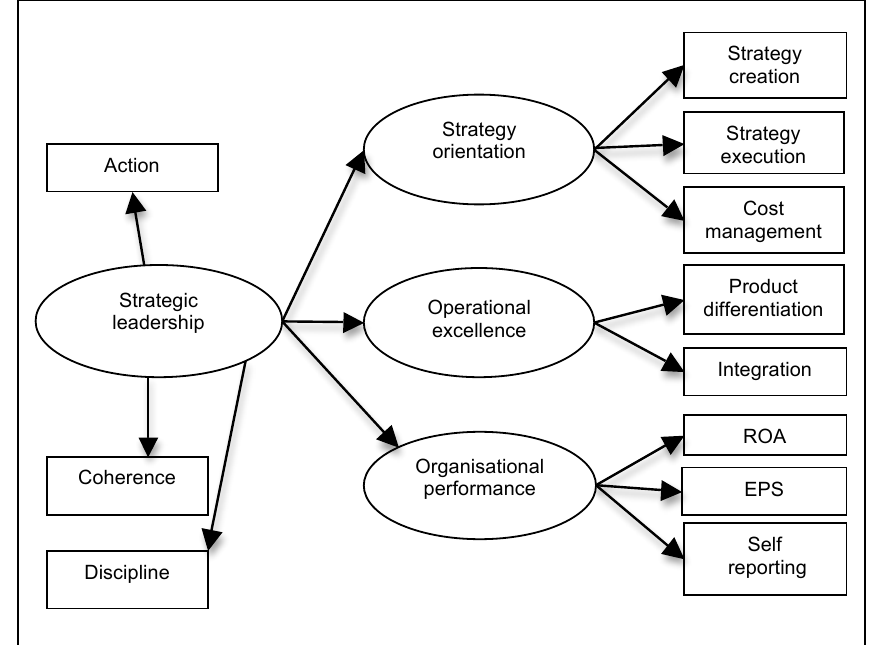
An illustration of the conceptual correlation model of strategic leadership, strategy orientation, operational excellence and organisational